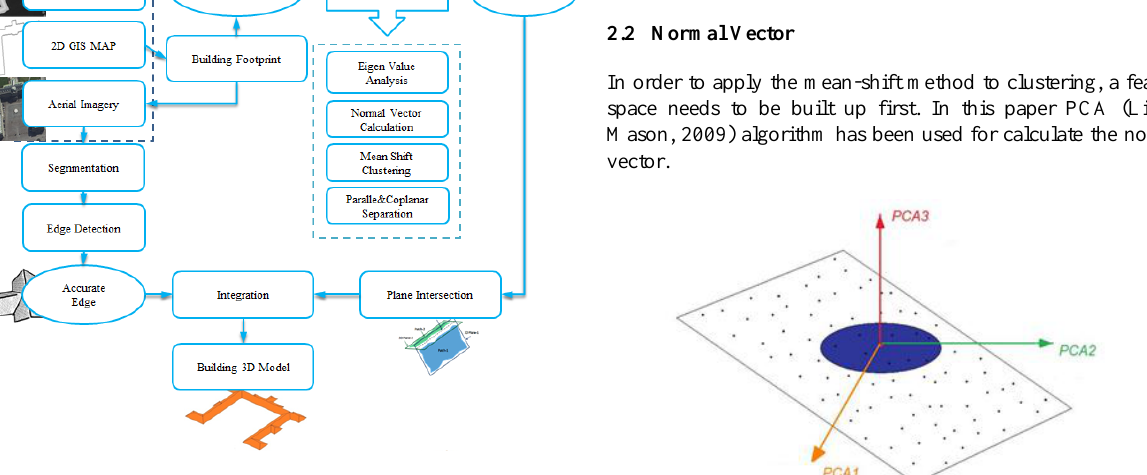
Figure 1. Workflow for the proposed method 3D building roof reconstruction.